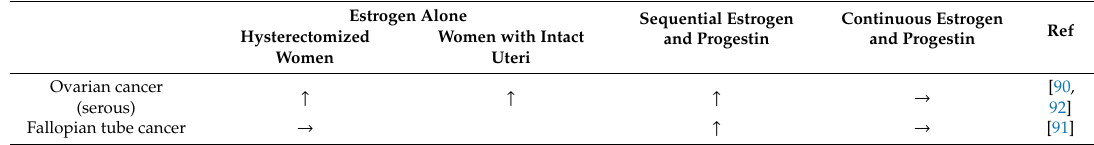
Table 3. Menopausal hormone therapy and risk of serous carcinoma. Estrogen Alone Sequential Estrogen Continuous Estrogen and Progestin and Progestin